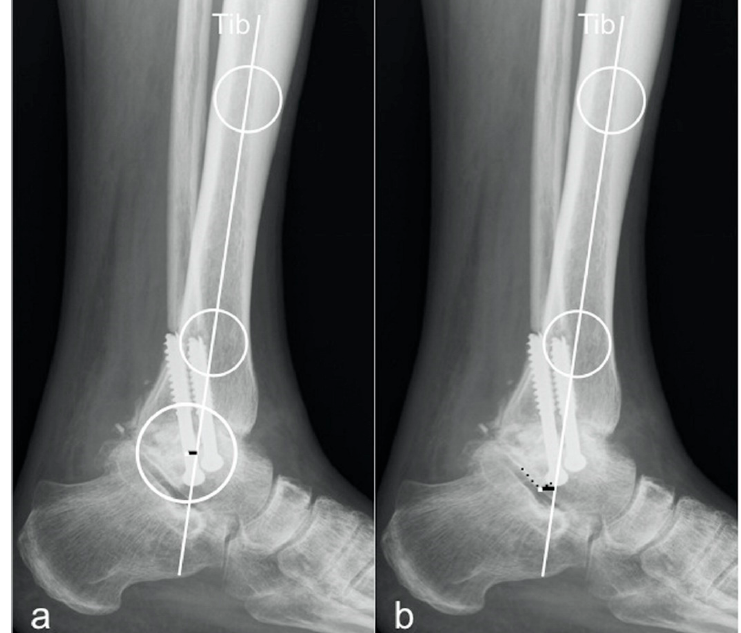
Figure 3. TibCOR and ProcLAT measurement for the tibio-talar offset measurement. Figures are depicting the two different methods for measuring the tibio-talar offset: the distance from the center of a circle manually fitted to the talar dome surface (representing the center of rotation of the ankle joint) and the longitudinal axis of the tibia ( a ), the distance from the tip of the lateral process of the talus to the longitudinal axis of the tibia ( b ).